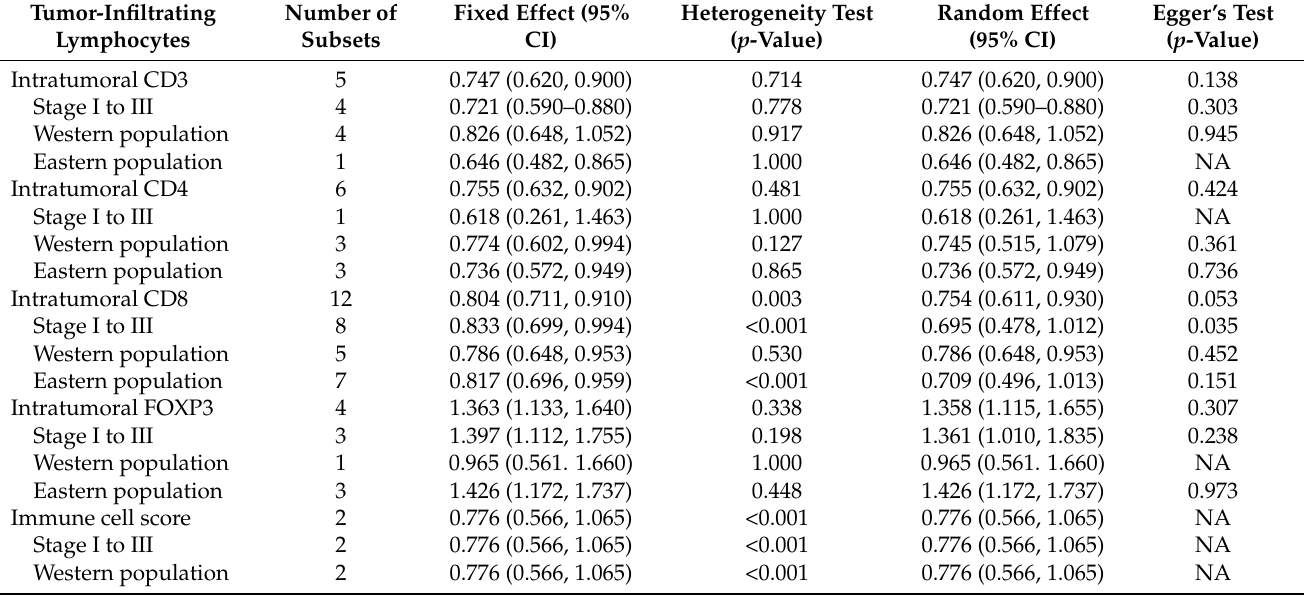
Table 2. Correlation between intratumoral infiltrating lymphocytes and overall survival in pancreatic ductal adenocarci-